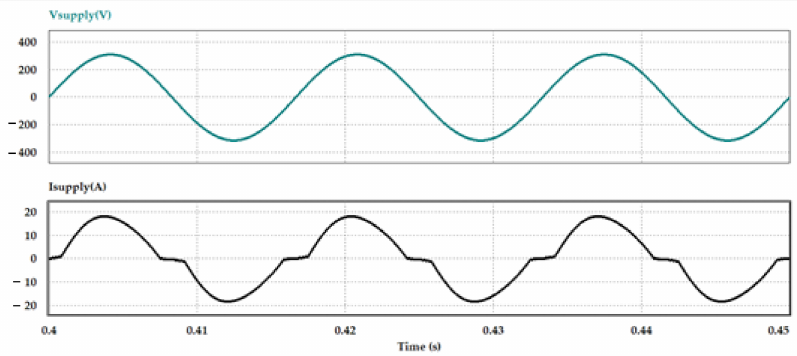
Figure 26. Waveforms of the supply current-voltage with the PI current